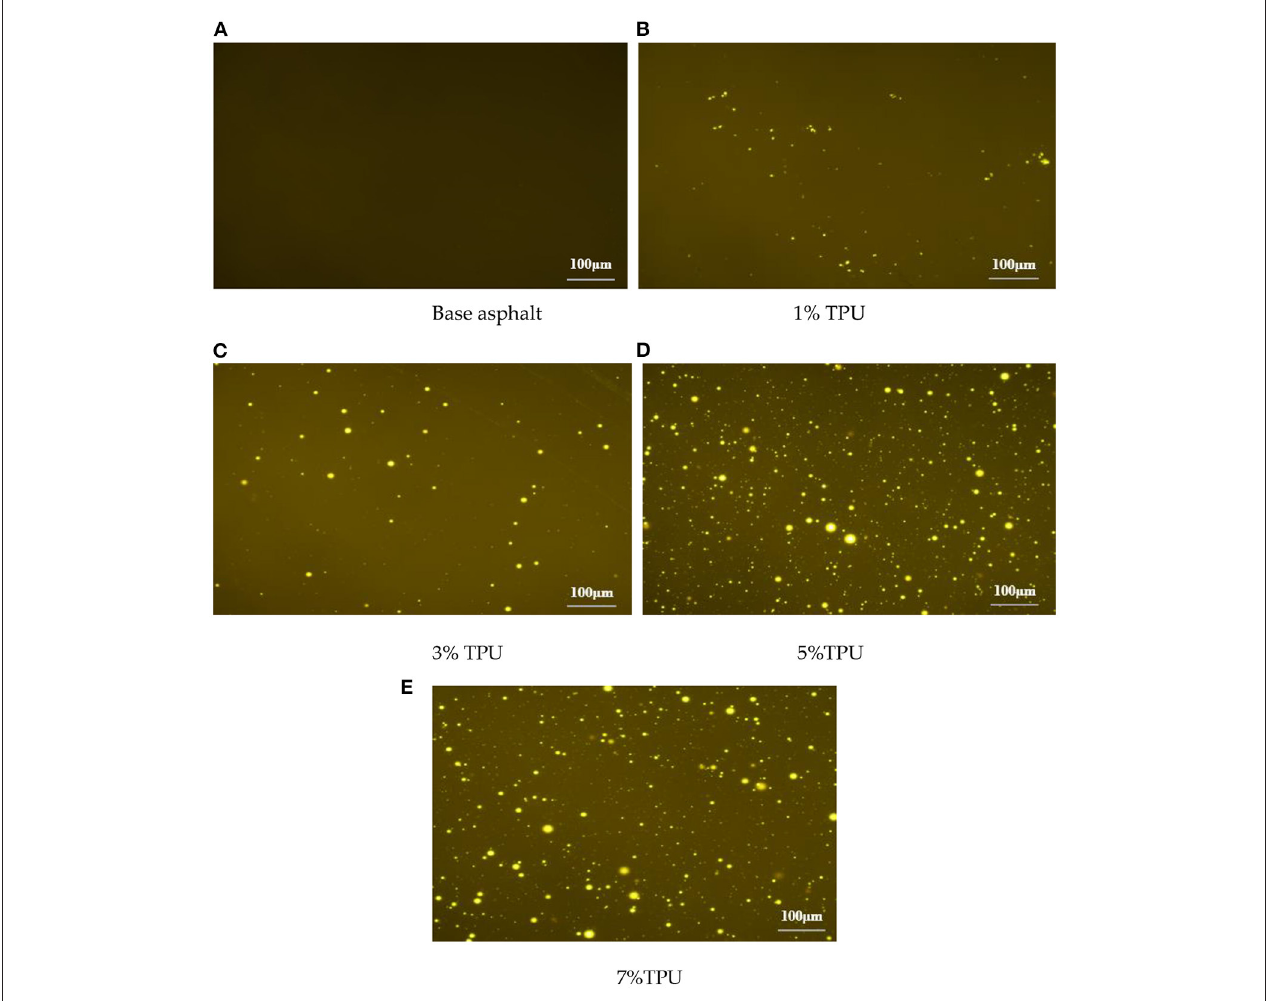
FIGURE 20 | Fluorescence micrographs of polyether-based TPU-modified asphalt. (A) Base asphalt. (B) 1% TPU. (C) 3% TPU. (D) 5%TPU. (E)